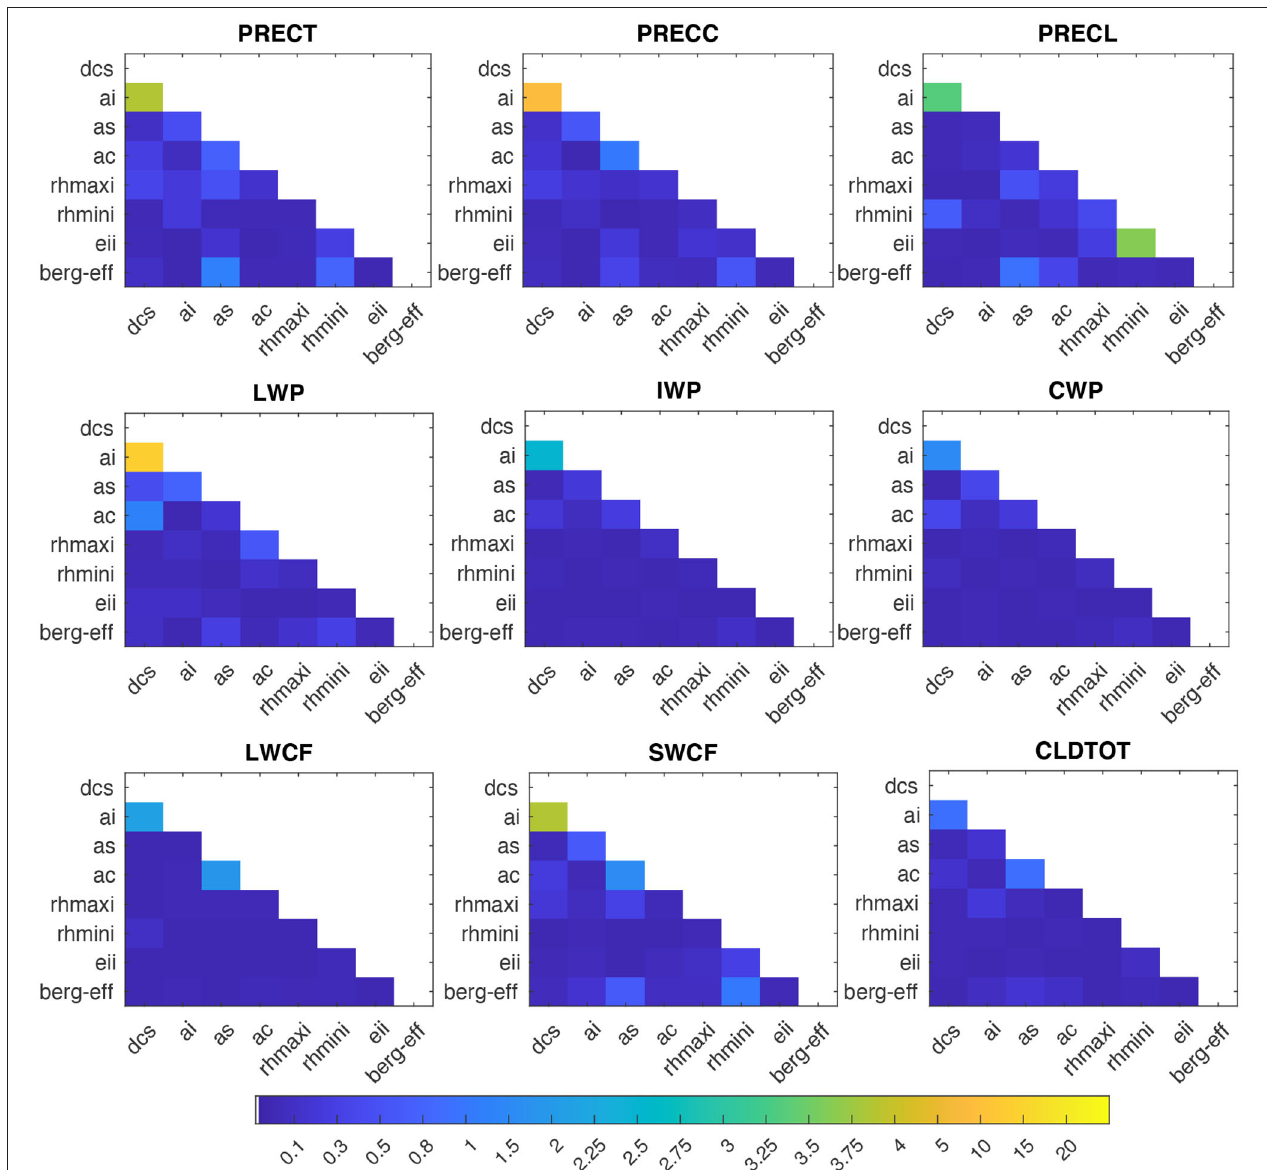
FIGURE 5 | Relative contributions (in %) from the interaction of a parameter with other parameters, to the total variance of PRECT, PRECC, and PRECL (in the first row), LWP, IWP, and CWP (in the second row), and LWCF, SWCF, and CLDTOT (in the third row), as estimated using the PC-fitted